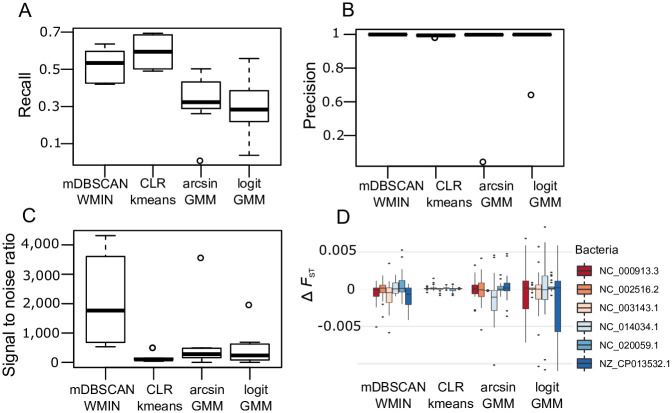
Metavariant clustering performances of four clustering algorithms.A. Recall of metavariant clusters. B. Precision of metavariant clusters. C. Signal to noise of metavariant clusters. D. Population pairwise-FST difference between MVS and the alignment-based method.